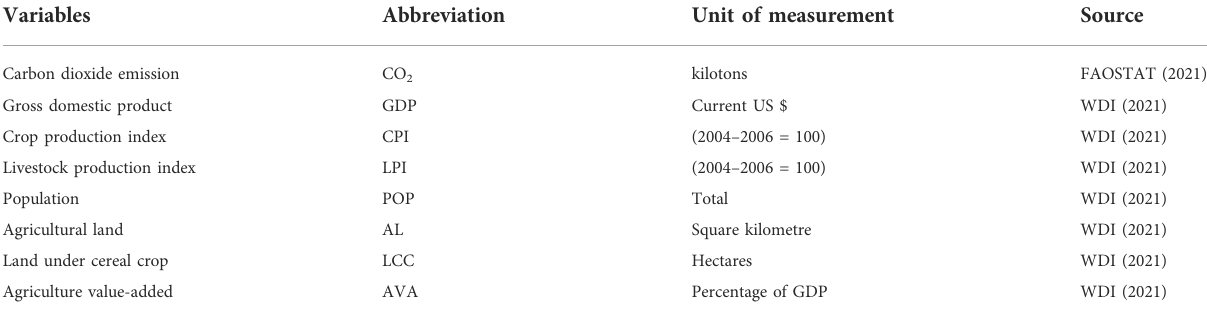
TABLE 1 Data elaboration and sources.